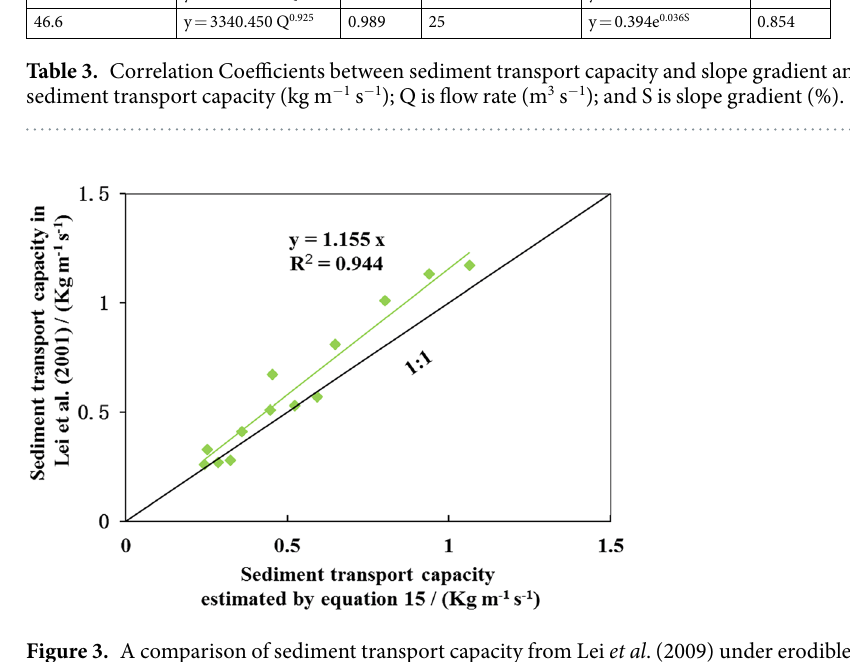
Figure 3. A comparison of sediment transport capacity from Lei et al . (2009) under erodible condition and estimated by eq. 4 ( T c = 40.311 S 0.551 q 0.861 , T c is sediment transport capacity (kg m − 1 s − 1 ), S is slope gradient (%) and q isdischarge per unit width (m 2 s − 1